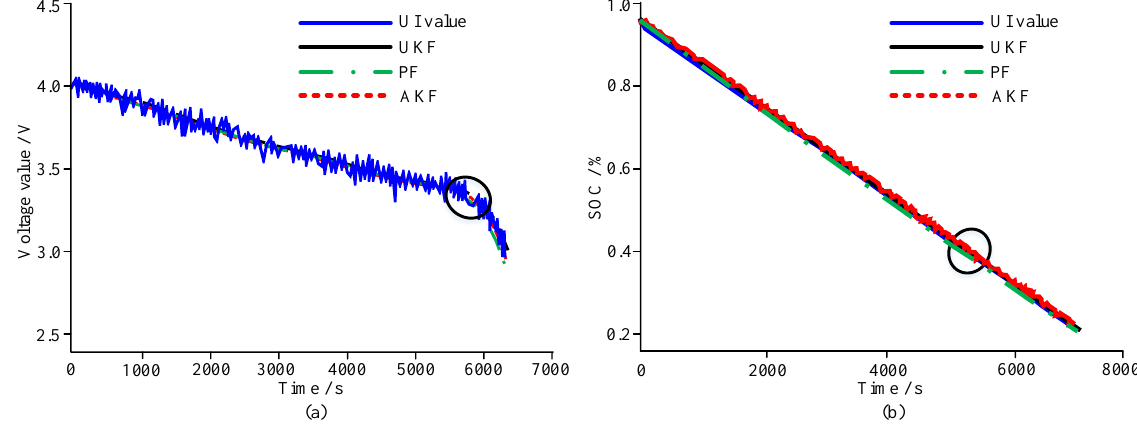
Figure 5. Estimated and reference values of battery terminal voltage and SOC A separate grid-connected simulation is carried out through the fan parameters. The grid load demand power and grid-connected power are shown in Figure 6. It can be seen from Figure 6 that there is a big difference between the power demanded by the grid load and the grid-connected power. Additionally, the requirements for the system distribution control performance are high. These two curves can judge the stability and security of the system effectively. In 0–2.0 min, 2.2–4.6 min, 11.7–14.1 min, and some other time periods, high-power loads were put into use without energy storage equipment, and the phenomenon of power shortage occurred. At 7.1–8.2 min, the wind speed changed greatly but the load power did not fluctuate. At this time, there was a large residual power in the system. After 13.9 min, the system load demand is less, and there is also a large residual power. Therefore, load changes and sudden changes in wind speed seriously affect the stability of the system power, resulting in unstable operation of the power grid. When the wind turbine is connected to the grid alone, the tracking results of parameters such as dq-axis current and torque show that the wind turbine has a better operation effect.